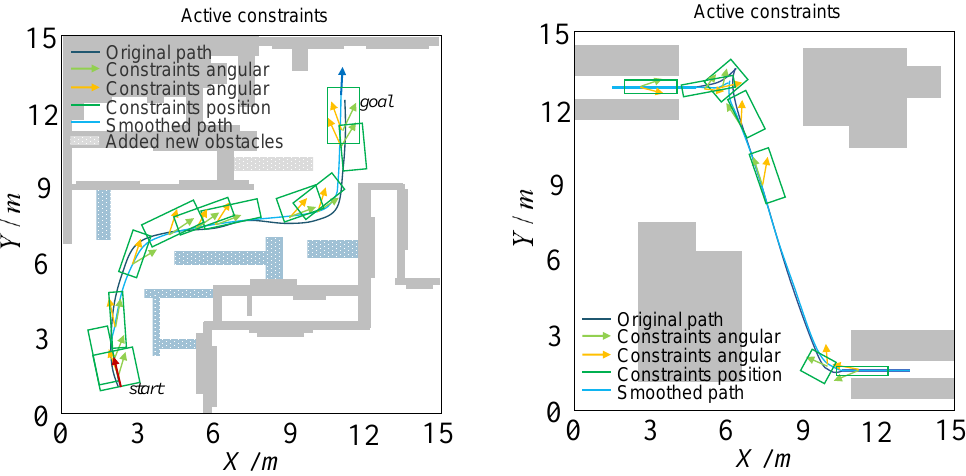
Figure 13. Obstacle expansion. Left : The same start and target poses were added to the map Figure 8 with additional obstacles. Right : Narrow and long test